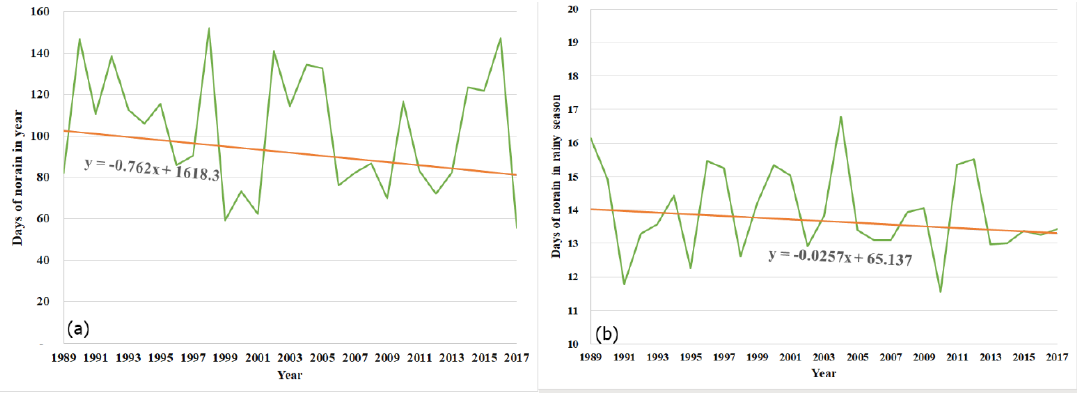
Figure 11. The number of consecutive days without rain ( a ) in a year and ( b ) in the rainy season. M-K tests for NRY and NRW values revealed a slight downward trend in NRY and little variation in NRW. However, the reliability, here, was not